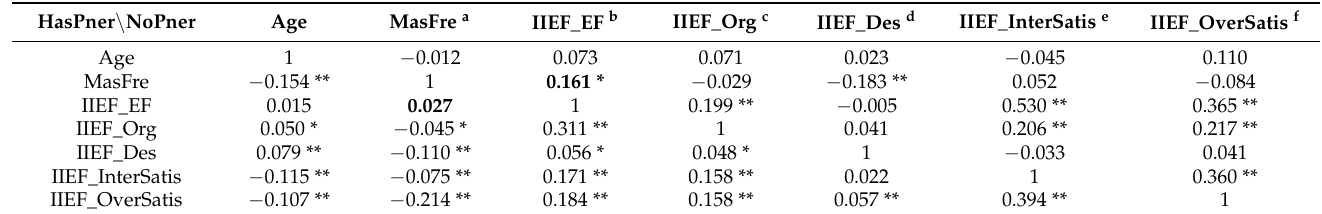
Table 3. Correlations between Age, Masturbation Frequency, IIEF_Erectile Function, IIEF_Orgasm Function, IIEF_Sexual Desire, IIEF_Intercourse Satisfaction, and IIEF_Overall Satisfaction for men who have a partner (in the below diagonal) and men who do not have a partner (in the above diagonal).